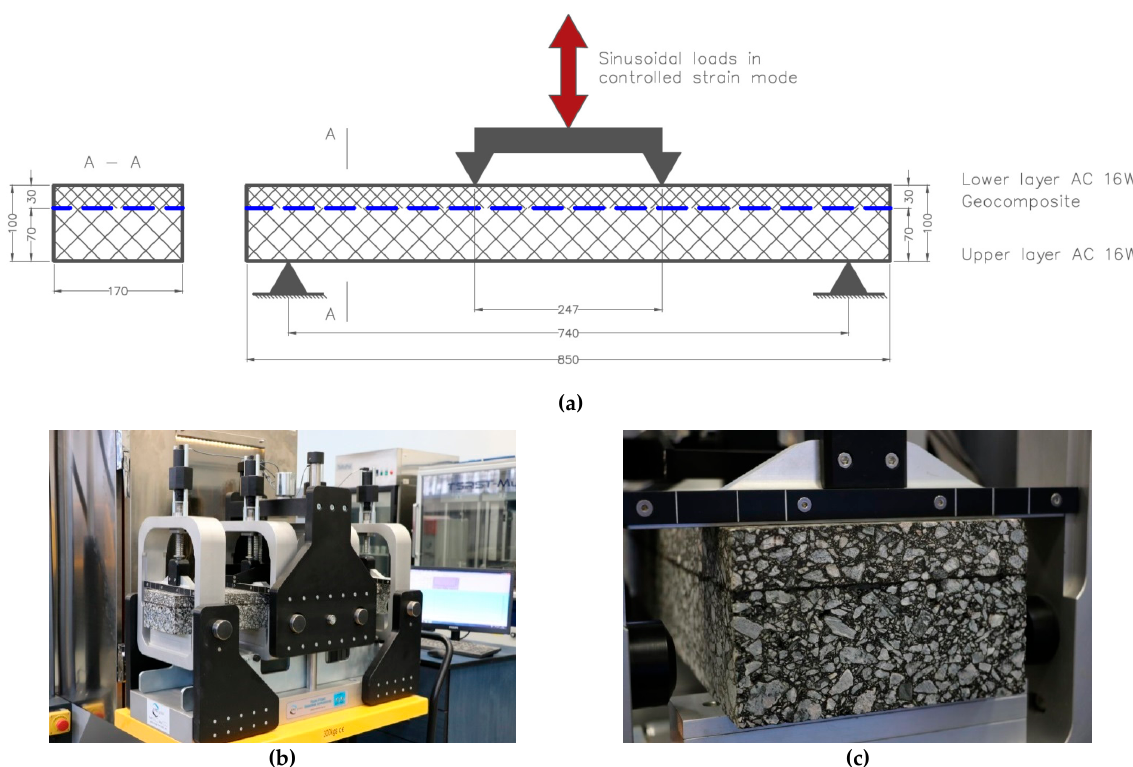
Figure 4. Four-point bending apparatus: ( a ) scheme of the 4PB test configurations (all dimensions in mm), ( b ) view of the test equipment outside the climatic chamber, ( c ) close-up of the beam cross-section.